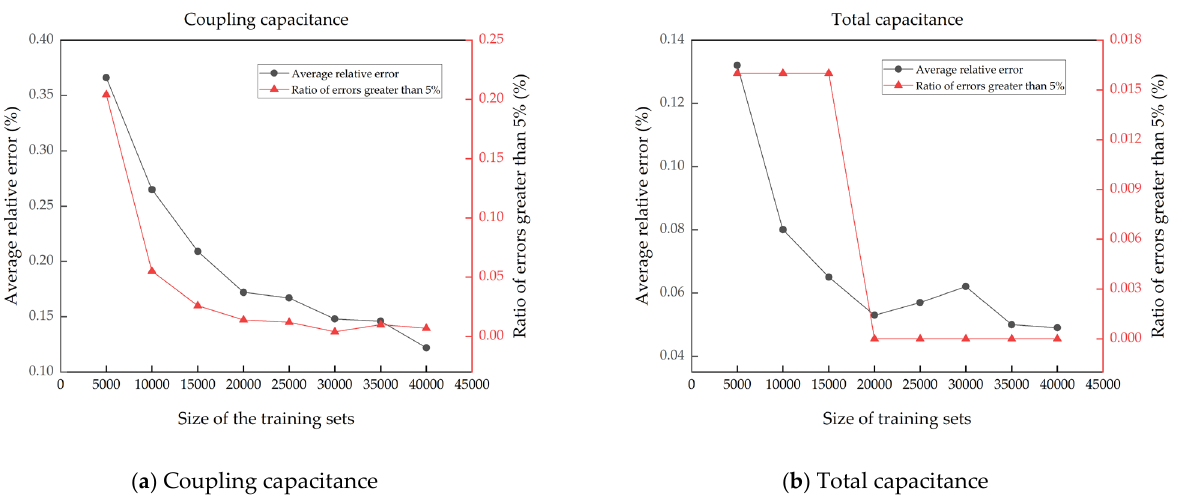
Figure 12. Distribution of average relative error and the ratio of errors greater than 5% under different sizes of training sets: ( a ) Coupling capacitance; ( b ) Total capacitance.